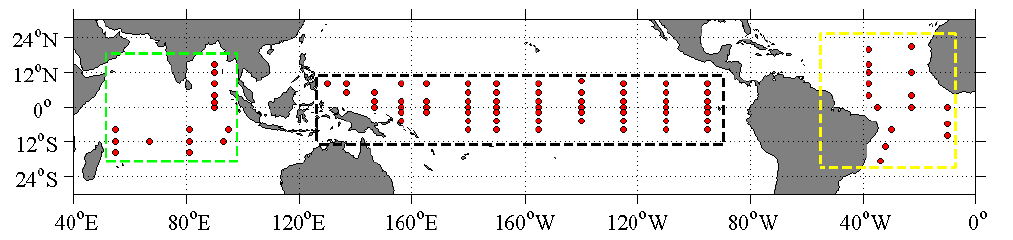
Figure 1. The distribution of selected buoy.